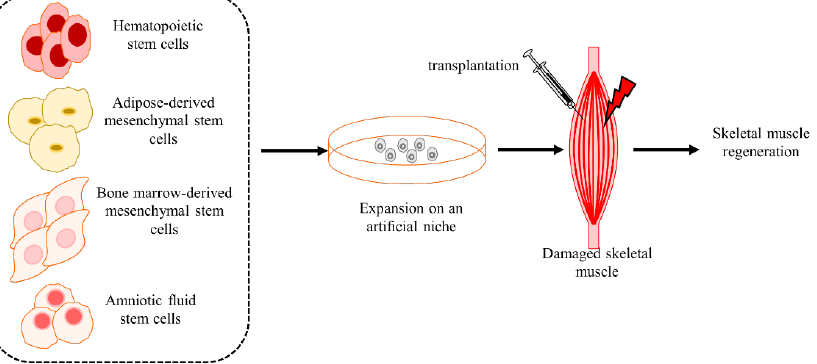
Figure 4. Non-SC stem cells regulate regeneration in CTX-induced injury muscle. Transplantation of hematopoietic stem cells, adipose-derived mesenchymal stem cells, bone marrow-derived mesenchymal stem cells, and amniotic fluid stem cells stimulate regeneration in the damaged skeletal muscle. Table 7. Non-SCs in the CTX-induced skeletal muscle injury models.